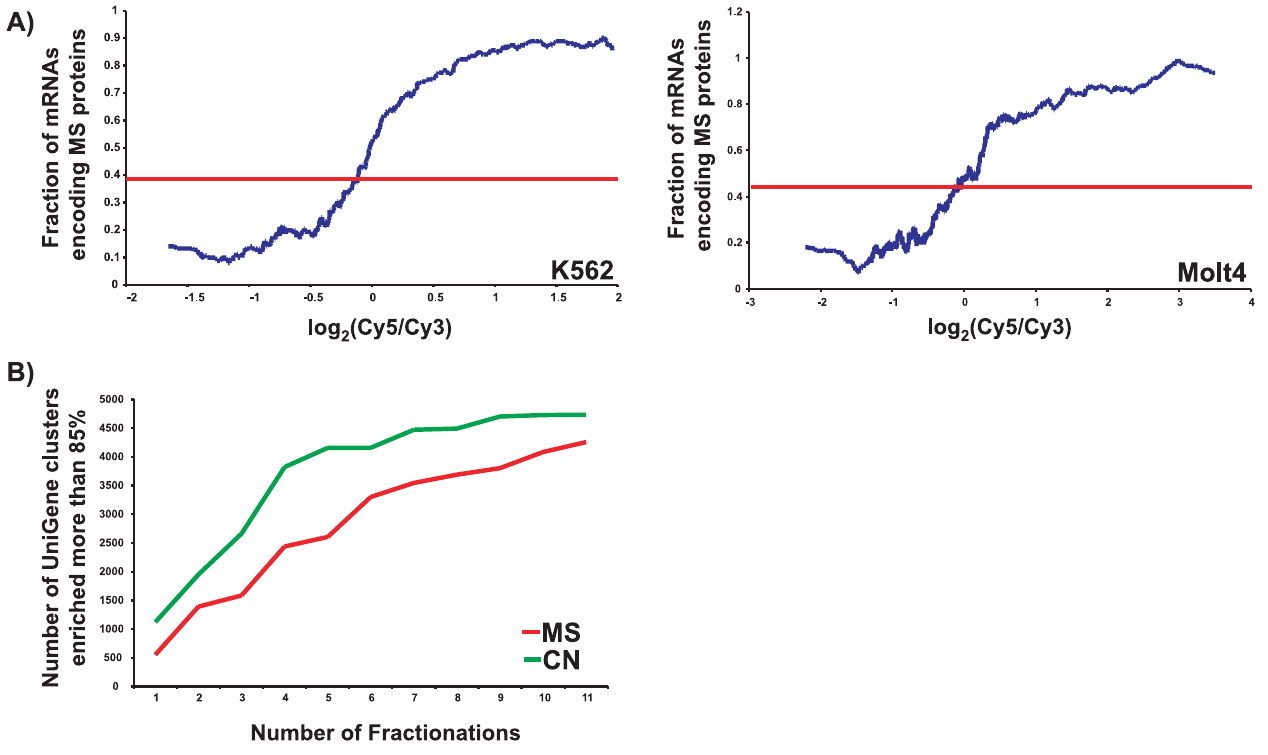
Figure 1. DNA Microarray Analysis of Subcellular mRNA Populations (A) Moving average analyses of the fraction of mRNAs encoding MS proteins. Data for two representative fractionations are shown. In each case, well- measured array elements representing characterized genes were extracted, and the local enrichment for MS-encoding genes (window size ¼ 151) was calculated as a function of the Cy5/Cy3 ratio. The horizontal line represents the overall fraction of MS genes on the microarrays used in these experiments. (B) Discovery rate analysis for the identification of MS and CN genes. A representative microarray hybridization was chosen for each cell line and the total nonredundant number of classified MS or CN genes (UniGene clusters) was calculated after each new fractionation. DOI: